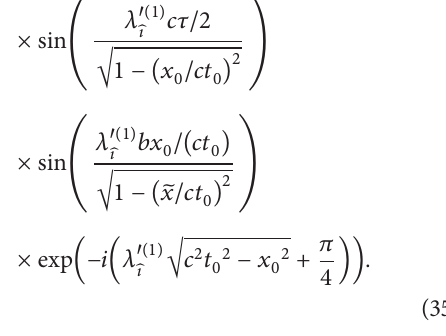
Figure 3: Reflection and transmission of amplitude coefficients on the left ( 𝐾 (𝑅) ) and right ( 𝐾 (𝑇) ) sides of a rectangular trench of depth ℎ 2 = 7000 m. The ocean depth on the left side of the trench is ℎ The bold numbers indicate the mode of incidence ̂𝚤 = 1 . The calculation error, err ̂𝚤 ≪ 10 −14 .